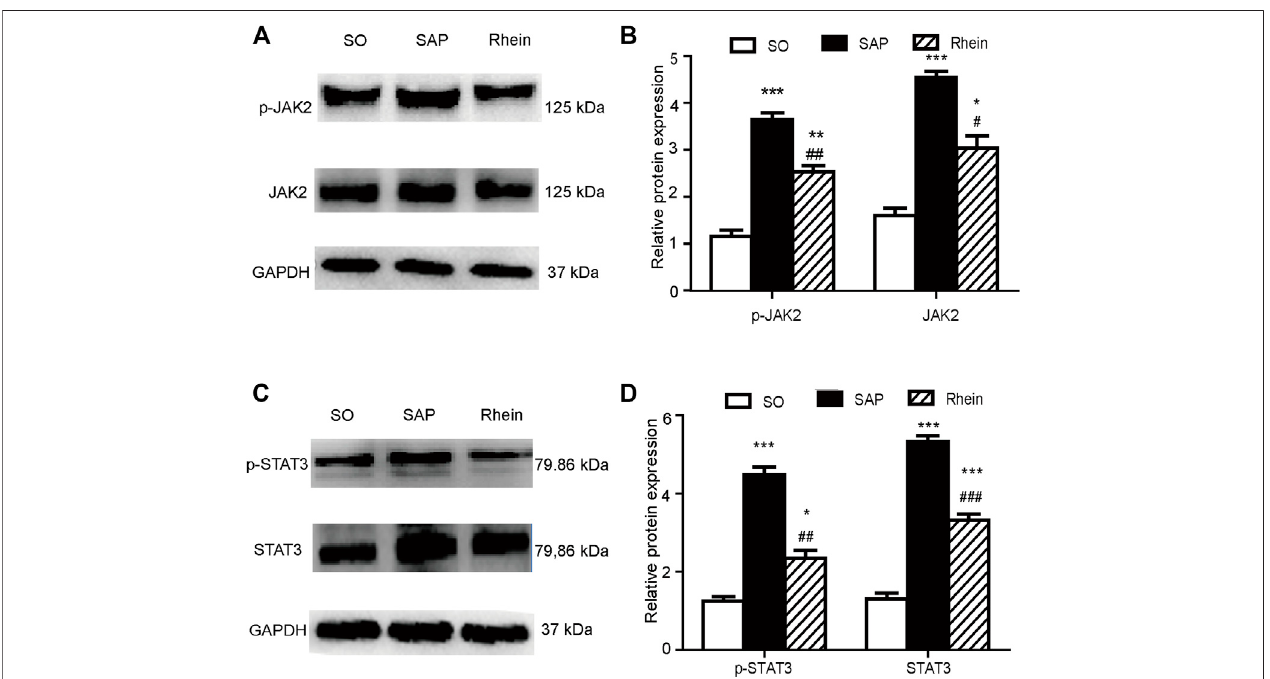
FIGURE 6 | Effects of rhein on p-JAK2, p-STAT3, JAK2 and STAT3 expression in pancreatic tissue of SAP rats. (A,B) p-JAK2 and JAK2 protein expression in the SO, SAP and rhein groups. (C,D) p-STAT3 and STAT3 protein expression in the SO, SAP and rhein groups. Data are expressed as mean ± SD ( n = 5 per group). Signi fi cancebetweengroupswasevaluatedbyonewayanalysisofvariance(ANOVA)followedbyaTukeyposthoctest.* p < 0.05,** p < 0.01and*** p < 0.001compared with the SO group; # p < 0.05, ## p < 0.01 and ### p < 0.001 compared with the SAP group. JAK2, janus kinase two; STAT3, signal transducer and activator of transcription three; SO, sham operation; SAP, severe acute